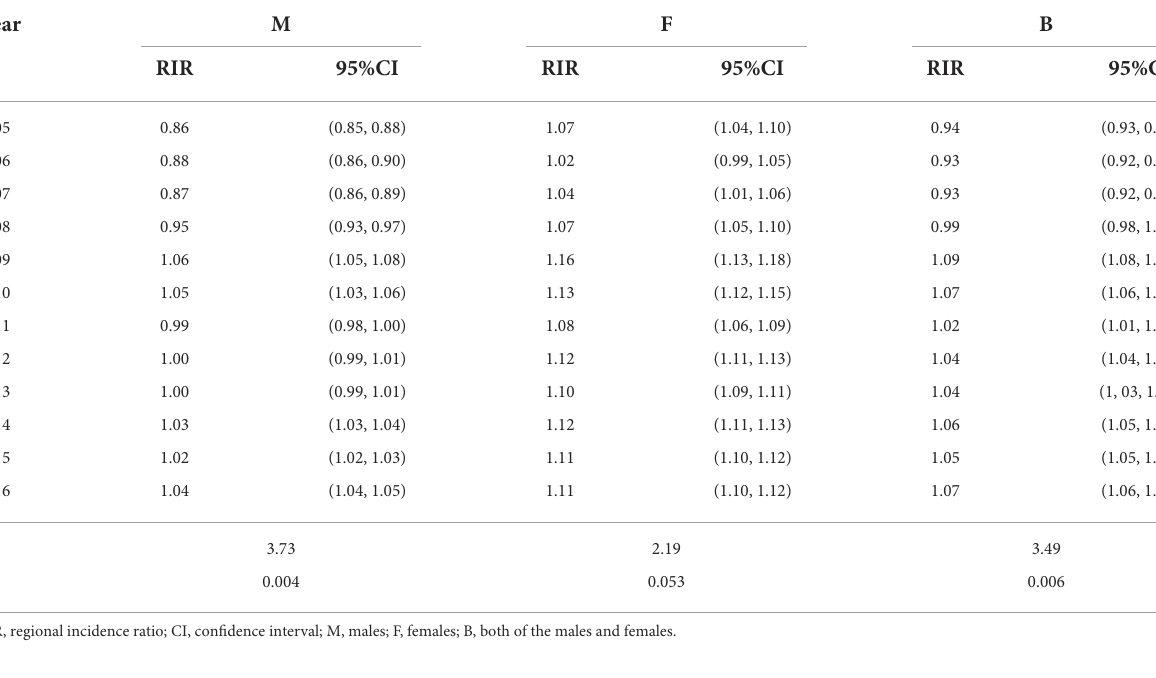
TABLE 4 The regional (urban/rural) incidence ratio in Chinese older adults aged 60 and above from 2005 to 2016.